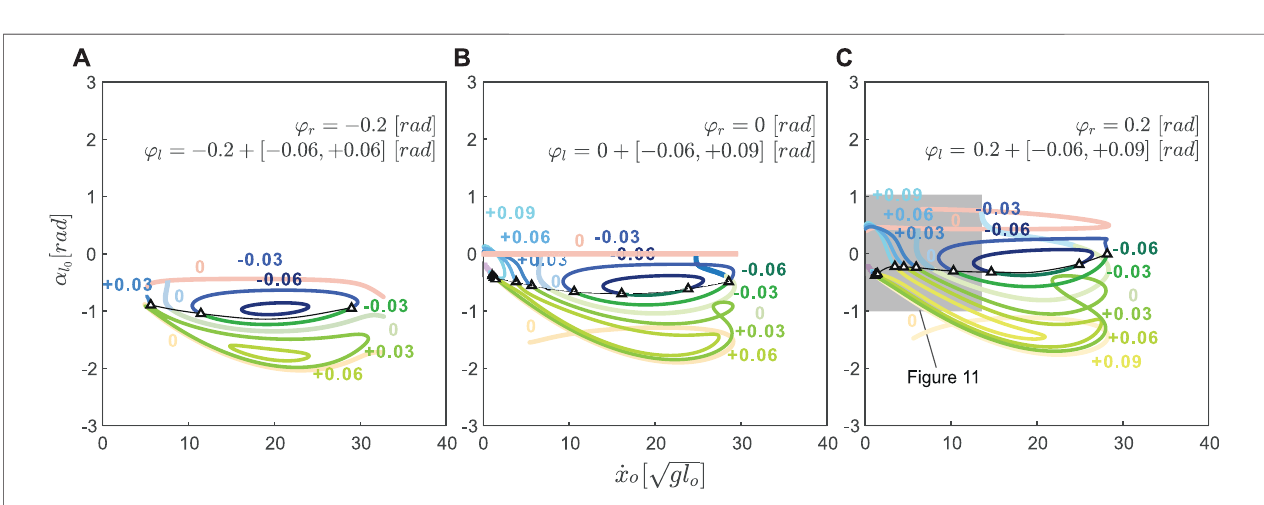
, light grey sector for α l ) and the neutral leg angles. 0 0